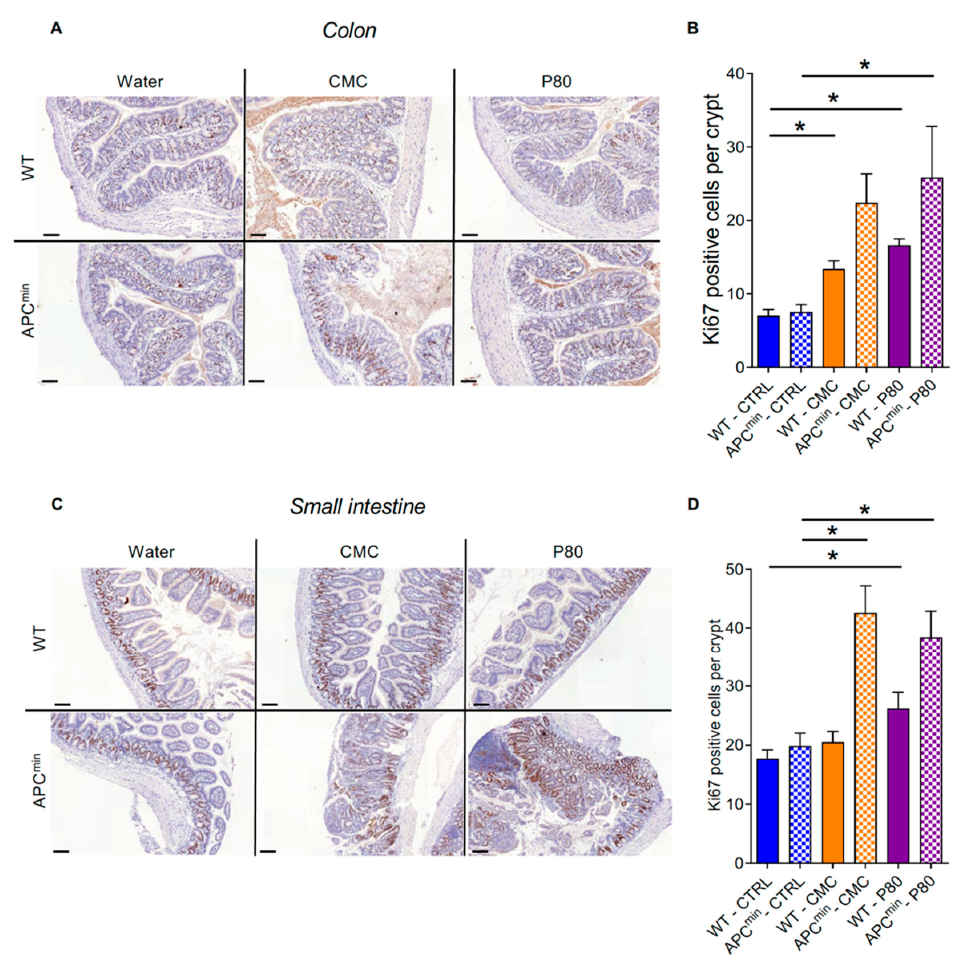
Figure 3. Dietary emulsifier consumption alters epithelial cell proliferation in WT and APC min mice. Seven-week-old WT and APC min female mice were exposed to drinking water containing CMC or P80 (1.0%) for 15 weeks. Epithelial cell proliferation was analyzed by immunohistochemistry using the proliferation marker Ki67 in colonic ( A , B ) and small-intestine ( C , D ) tissue sections. ( A ) Representative images of Ki67 staining in colonic tissue sections. Scale bar, 100 µm. ( B ) Ki67-positive cells were counted and averaged per crypt in colonic tissue sections. ( C ) Representative images of Ki67 staining in small-intestine tissue sections. Scale bar, 100 µm. ( D ) Ki67-positive cells were counted and averaged per crypt in small-intestine tissue sections. Data are the means +/ − S.E.M. ( n = 11 for the WT–CTRL group, 4 for the APC min –CTRL group, 5 for the WT–CMC group, 5 for the APC min –CMC group, 5 for the WT–P80 group and 6 for the APC min –P80 group). Significance was determined using one-way ANOVA with a Bonferroni test (* indicates statistical